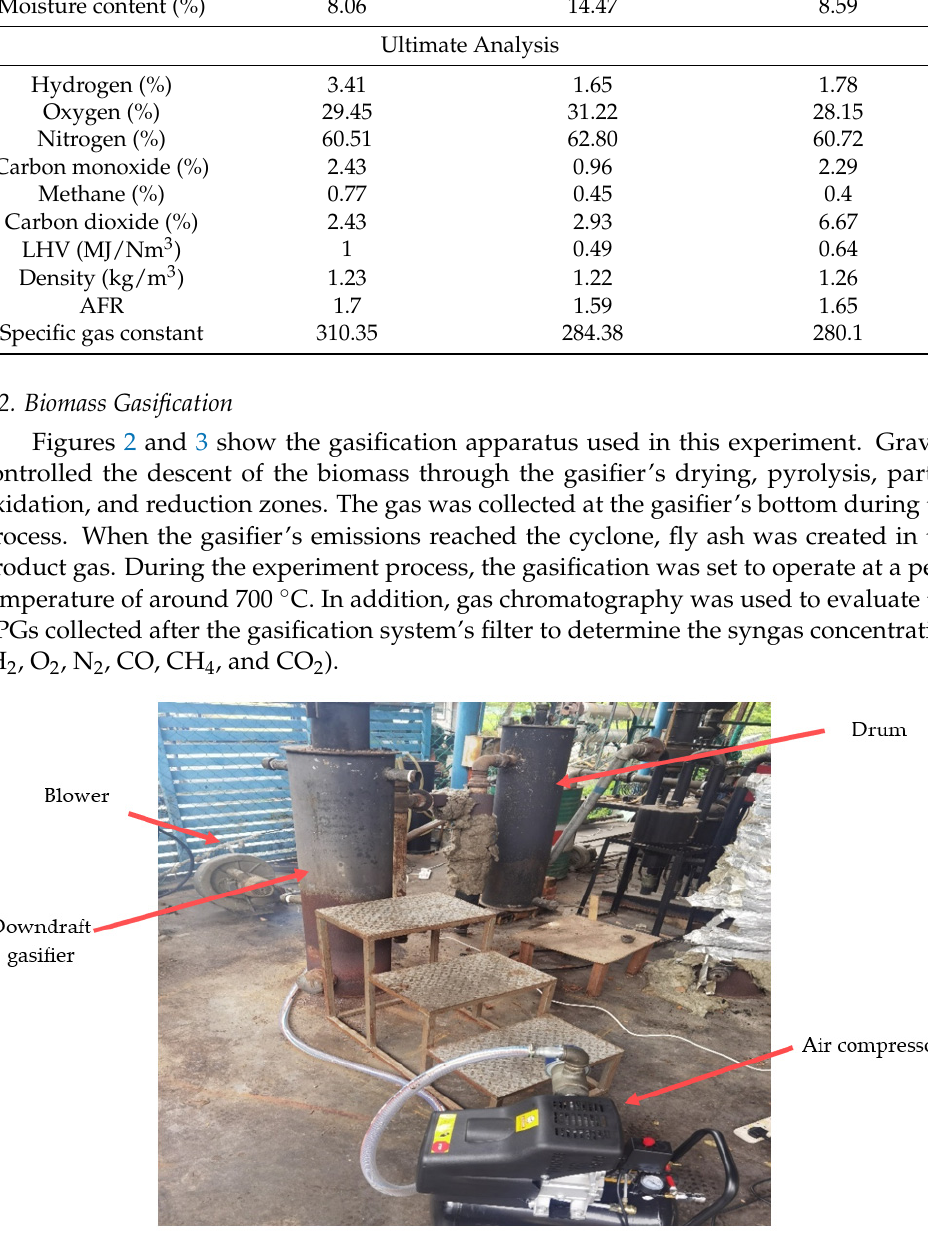
Figure 2. Setup of gasification.